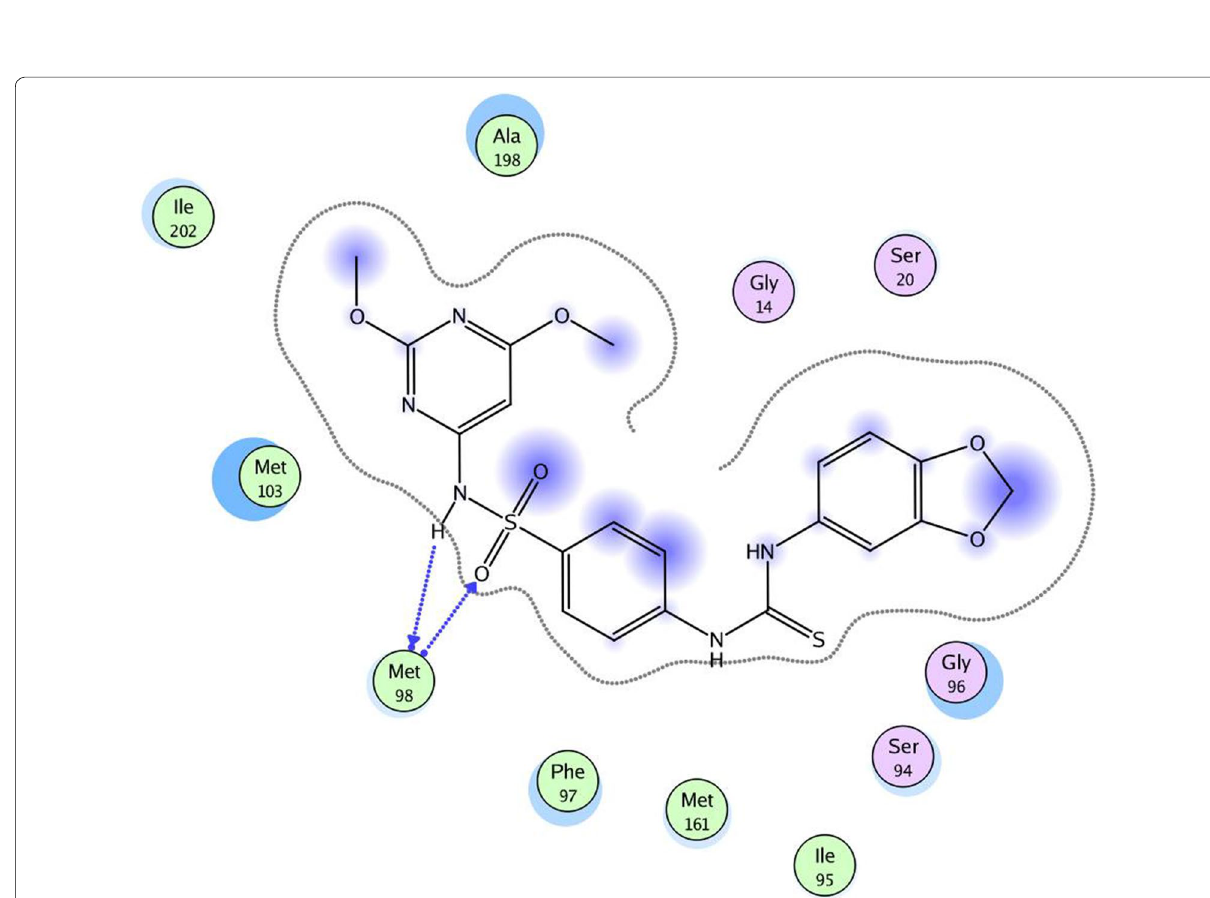
Fig. 3 2D interactions of compound 3i with the active site amino acids of